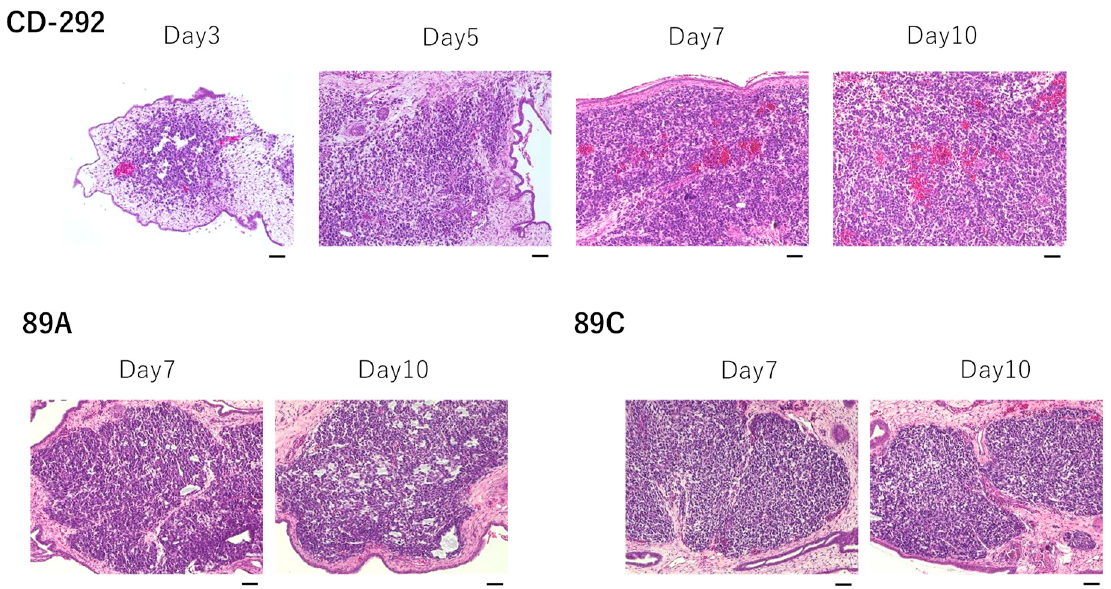
Figure 2. H&E staining of CAM tumors established by transplanting CD-292, 89A or 89C cells. Scale bar represents 0.05 mm.